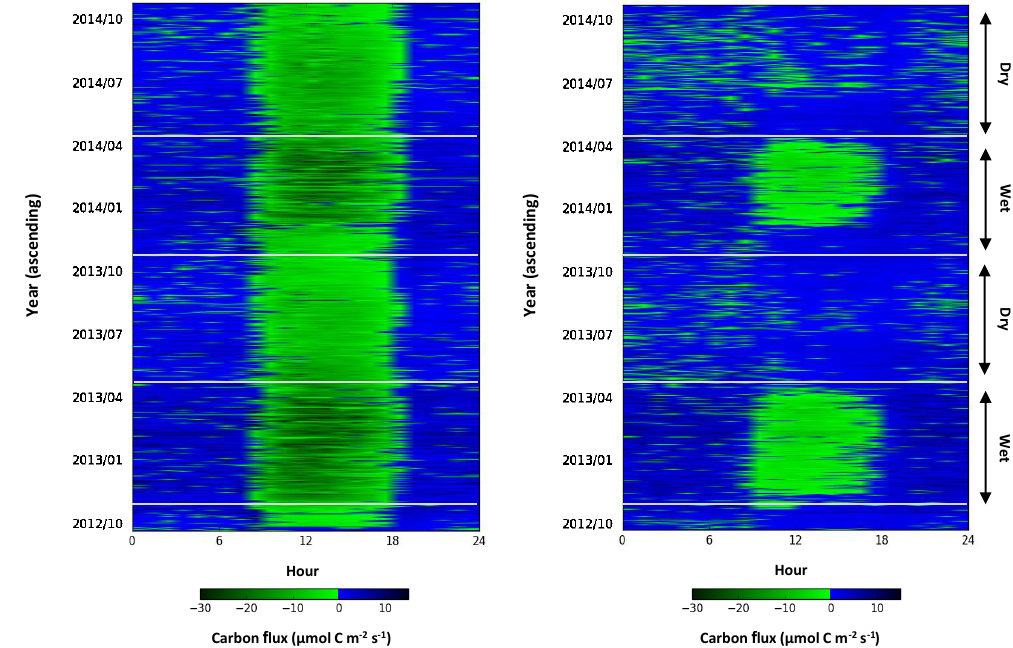
Figure 6. Diurnal ( x axis) fingerprint plot of NEE from the savanna (a) ecosystem (23m tower) and (b) understory (5m tower). Measurements shown are for “wet” and “dry” seasons from September 2012 to October 2014 ( y axis) at the Howard Springs OzFlux site, Northern Territory, Australia. Negative NEE represents the uptake of carbon by the savanna, whereas positive NEE represents the loss of carbon from the savanna.